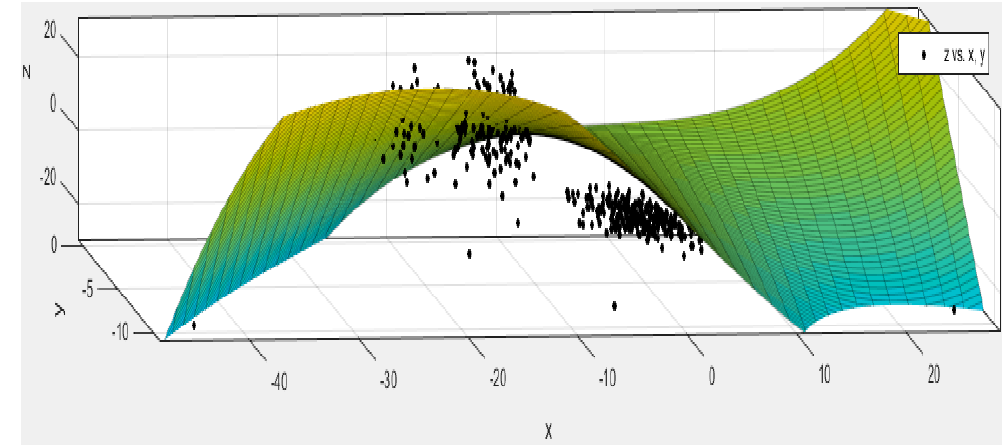
Figure 12. Fitting chart of traffic flow data at 15 s interval.